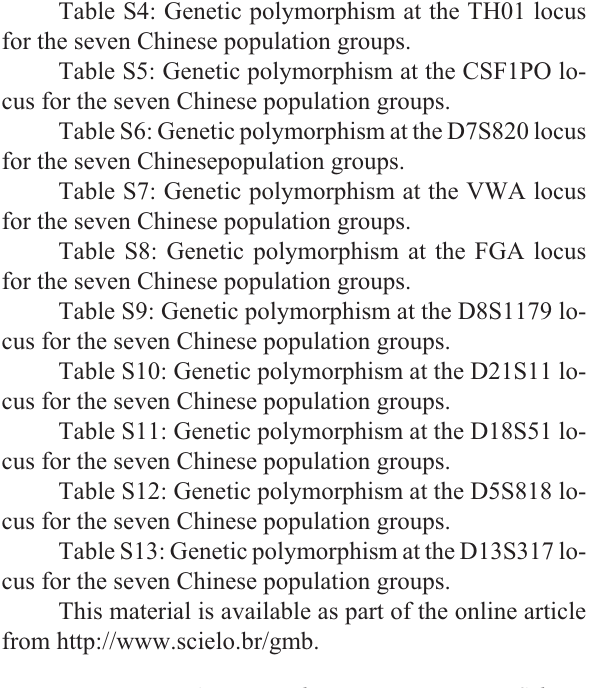
Table S1: Genetic polymorphism at the D3S1358 lo- cus for the seven Chinese population groups. Table S2: Genetic polymorphism at the D16S539 lo- cus for the seven Chinese population groups. Table S3: Genetic polymorphism at the TPOX locus for the seven Chinese population groups.